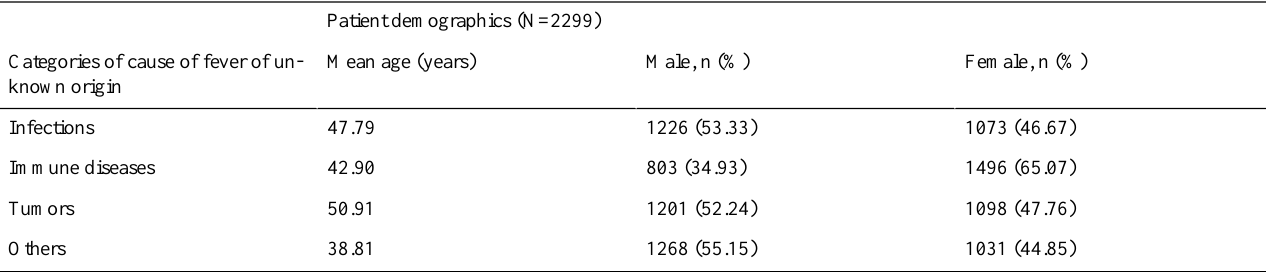
Table 1. Patient distribution in the data